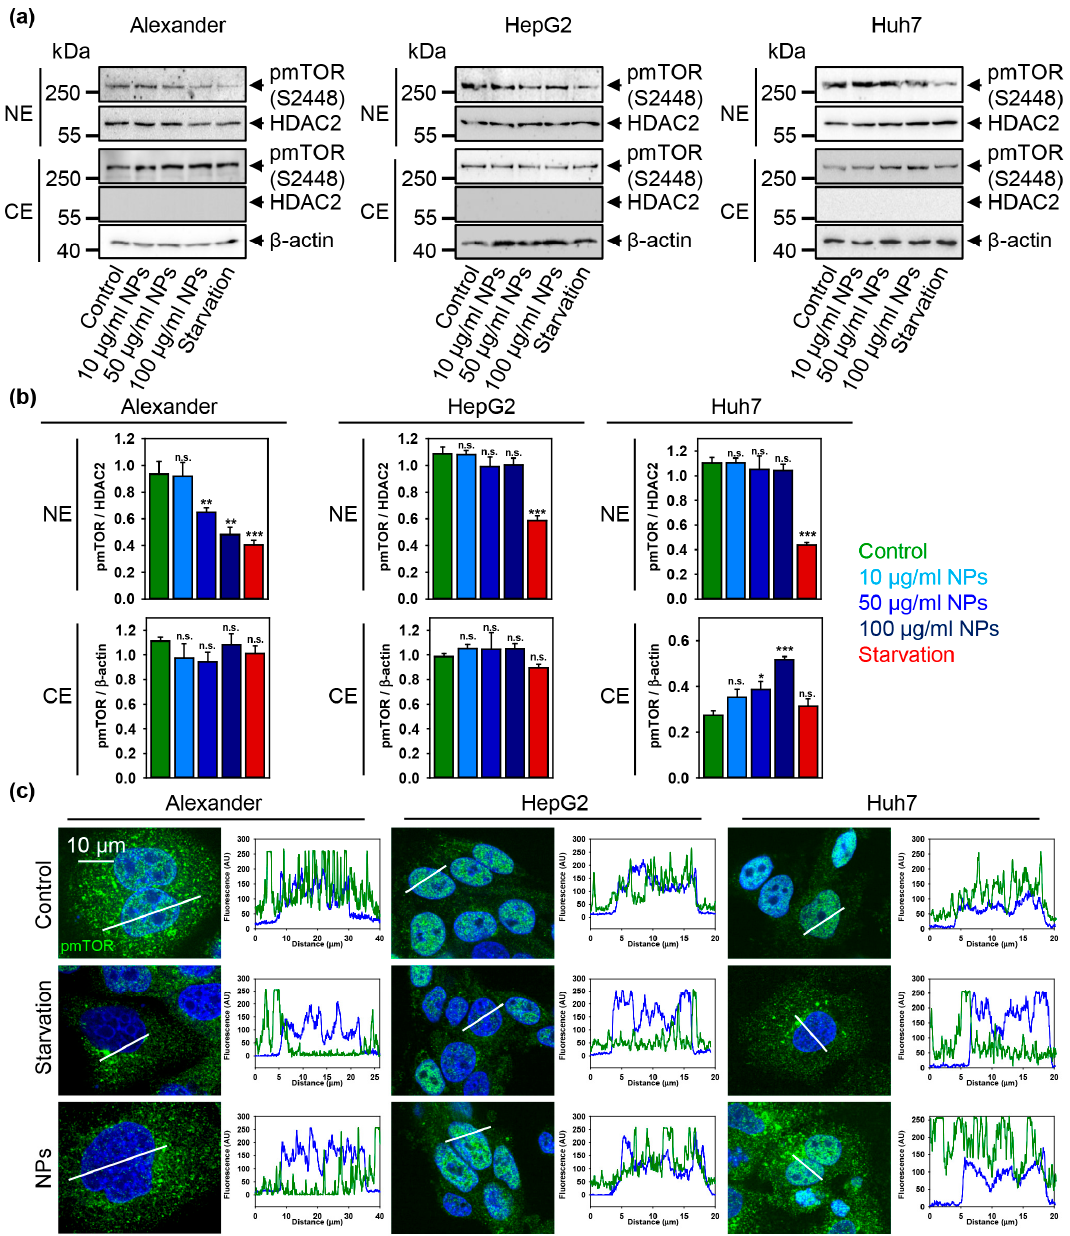
Figure 7. Sub-cellular localization of pmTOR is a ff ected by nanoparticles. ( a ) The cytosolic (CE) and nuclear extracts (NE) from cells treated with indicated concentrations of nanoparticles. Cells were treated for 12 h with nanoparticles. HDAC2 serves as a nuclear marker. Expressions of pmTOR was analyzed by immunoblotting. Positive control—serum starvation for 12 (Alexander, Huh7) and 14 (HepG2) h. Actin denotes loading control. ( b ) Densitometric quantification of blots ( a ). The data are expressed as mean ± SEM. (*) p < 0.05, (**) p < 0.01 and (***) p < 0.001 denotes significant di ff erences with respect to control (no particles treatment). ( c ) Sub-cellular localization of pmTOR upon nanoparticle treatment. Representative confocal microscopic images and linescans of three cell lines. Cells were treated for 12 h with nanoparticles 50 µ g Fe mL − 1 , fixed and immunostained for pmTOR (green). Positive control—serum starvation for 12 (Alexander, Huh7) and 14 (HepG2) h. Nuclei were stained with Hoechst 33342.